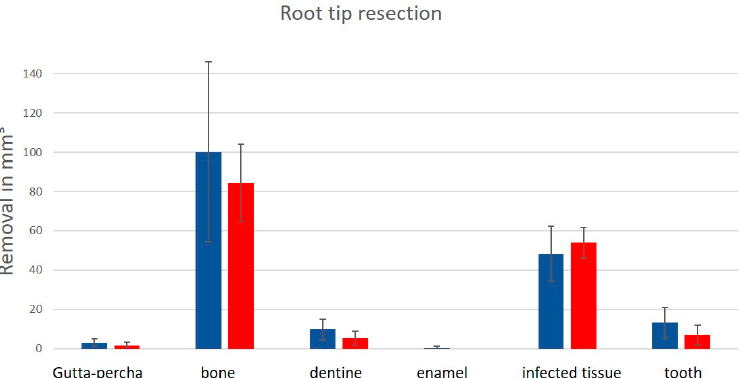
Figure 5. The removal of the parameters (gutta-percha, bone, dentine, enamel, infected tissue and tooth) during the virtual apicoectomy; blue: students; red: dentists. There was no significance between groups as determined by the Mann-Whitney U -test for p = 0.020 (gutta-percha); p = 0.010 (dentine); p = 0.009 (tooth) ( p < 0.0083).